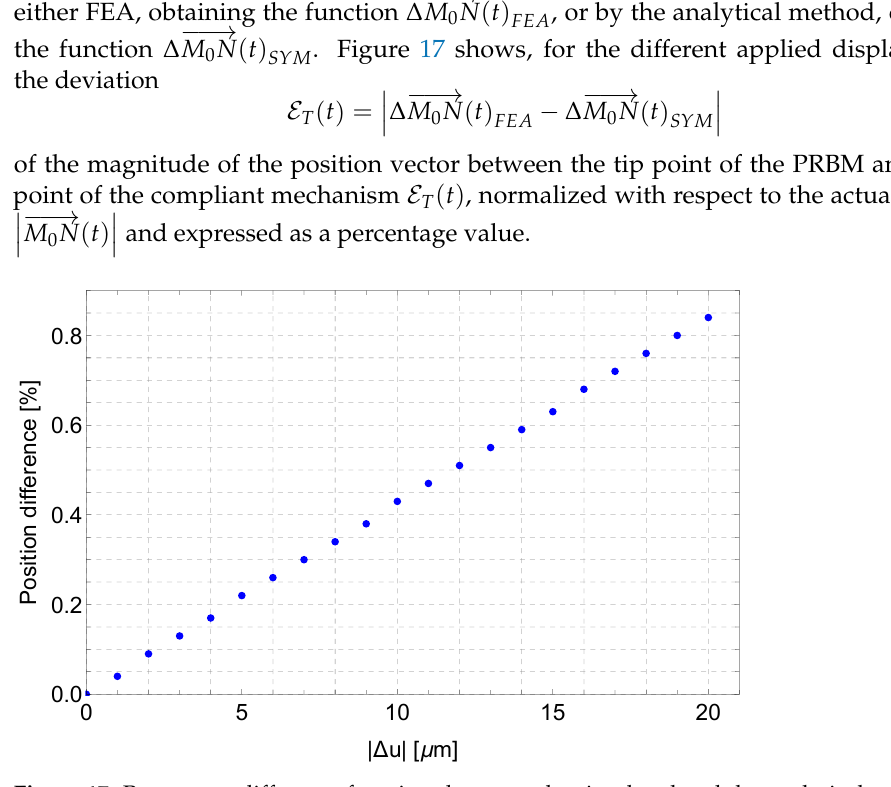
Figure 17. Percentage difference functions between the simulated and the analytical paths. Input displacements vary from ∆ u = − 1 µ m to ∆ u = − 20 µ